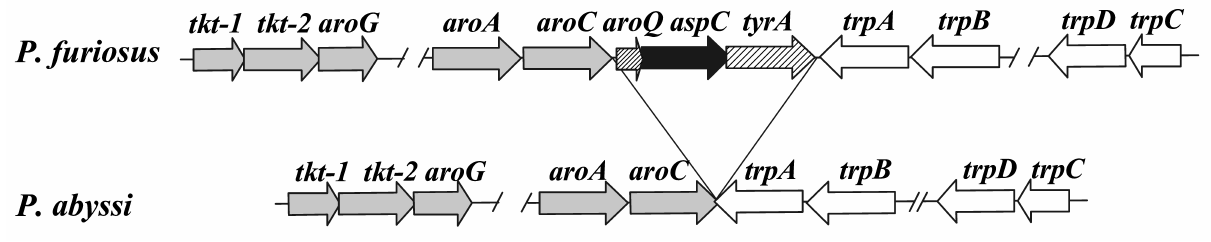
Figure 1. Molecular organization of the aro gene cluster and the AspAT ( aspC ) in P. furiosus and P. abyssi : aroQ , putative monofunctional chorismate mutase; aspC , aspartate aminotransferase; tyrA , putative prephenate